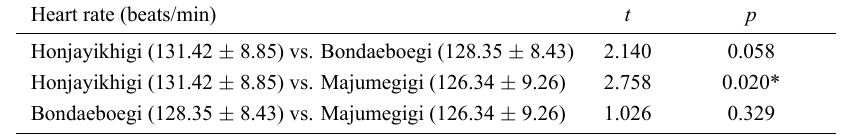
Data are expressed as mean ± standard